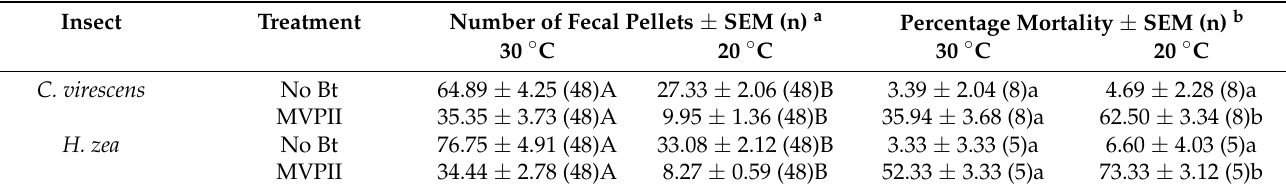
Table 1. Variation in fecal production after 24 h and percentage mortality after 7 days for Cry1Ac- susceptible Chloridea virescens and Helicoverpa zea neonates on artificial diet (without and with MVPII- Cry1Ac toxin in the diet) at 30 and 20 ◦